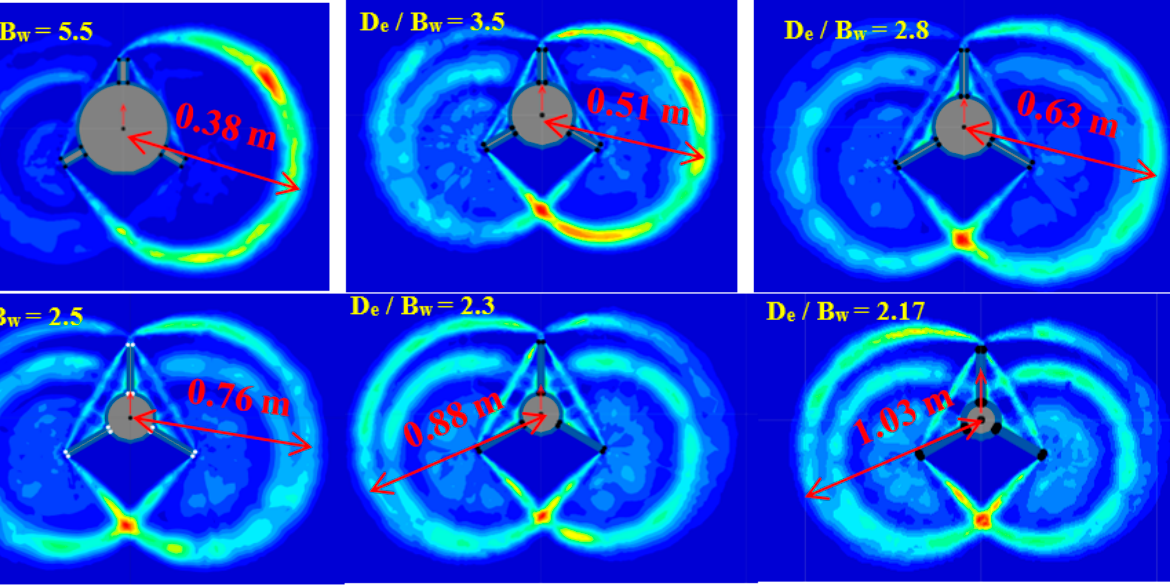
Figure 6. Influence of various wing–diameter ratios of the three-wing pile on the shear plastic zone of the soil when load angle β = 0 and pile–soil interaction coefficient a = 0.4. ( D e : effective diameter; B w : wing width.).